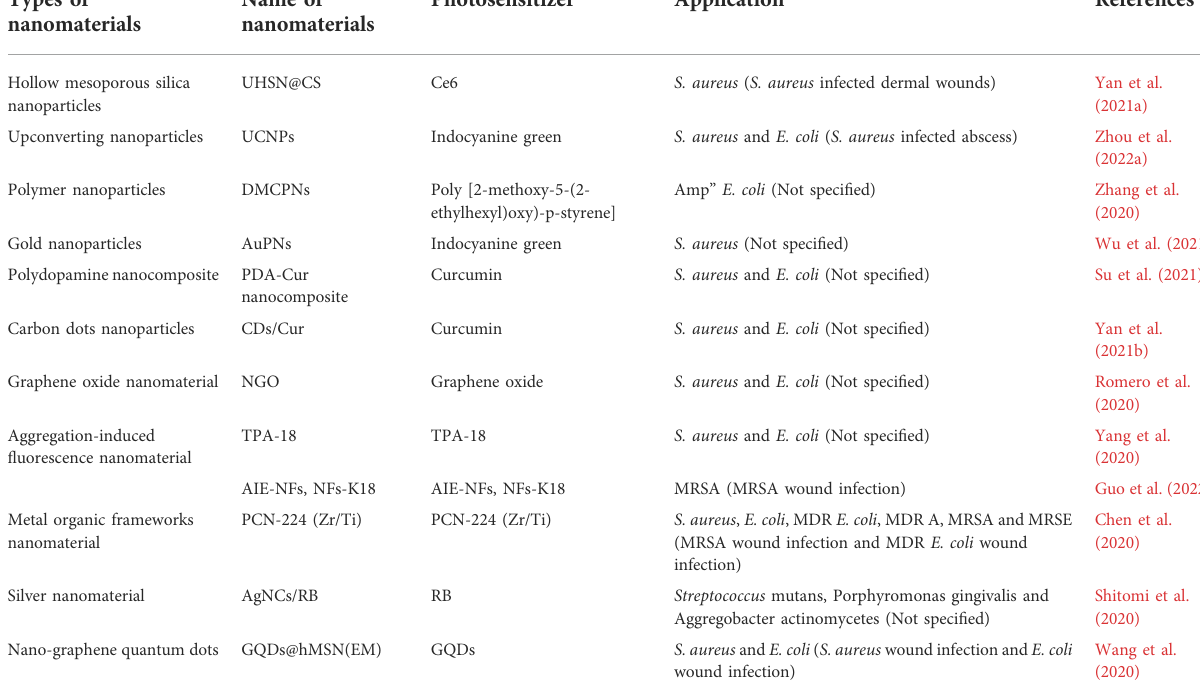
TABLE 1 Summary of nanomaterials for